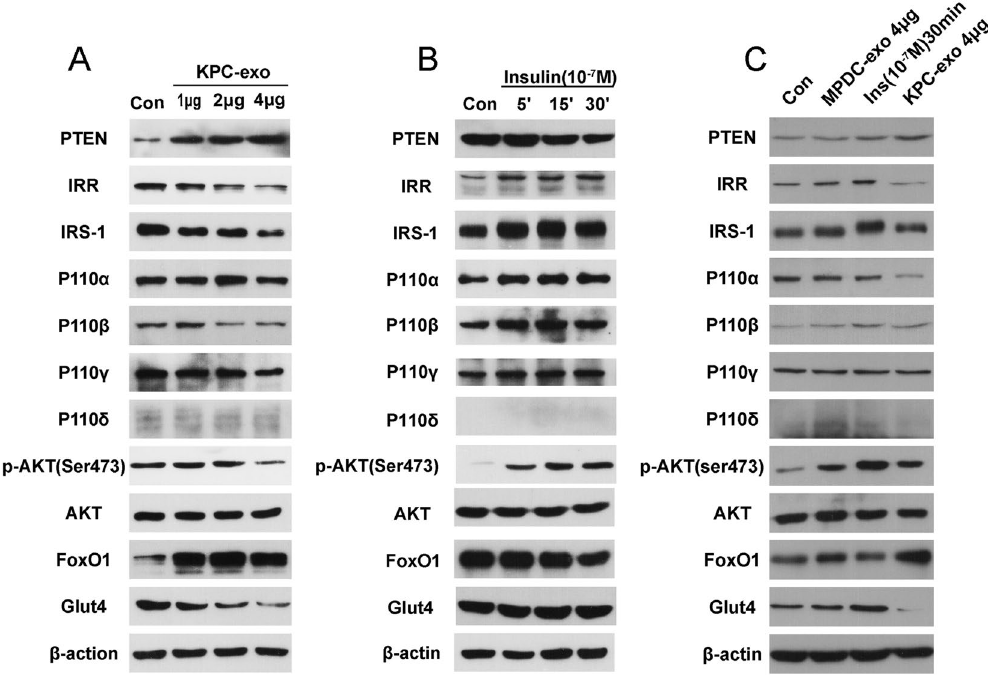
Figure 3. KPC-exosomes down-regulate the insulin and PI3K/Akt signalling pathway. To verify insulin and PI3K/Akt signalling pathway activation, the expression of some of the best characterized components and related targets was determined by western blot analysis. Differentiated C2C12 cells were cultured in 25-cm 2 culture-flasks with 5 ml DMEM medium. ( A ) Differentiated C2C12 cells were treated with KPC-exosomes (1 μ g, 2 μ g, 4 μ g) for 24 h. ( B ) Differentiated C2C12 cells were treated with insulin (10 − 7 M) for 5 min, 15 min, or 30 min. ( C ) Differentiated C2C12 cells were treated with 4 μ g MPDC-exosomes for 24 h, 10 − 7 M insulin for 30 min, or 4 μ g KPC-exosomes 24 h. MPDC-exosomes were employed as a negative